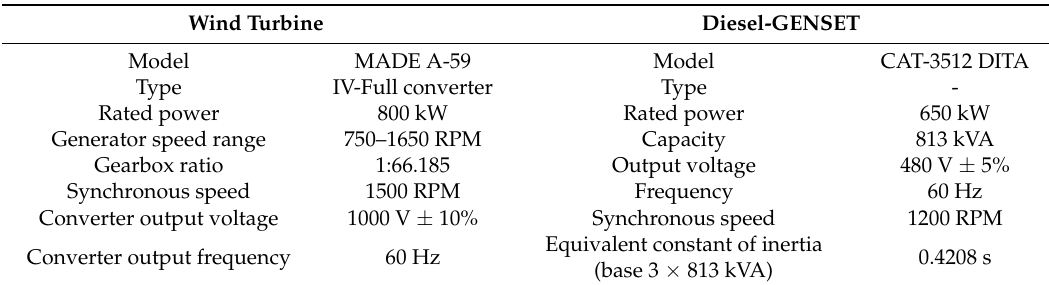
Figure 1. Wind-diesel hybrid power system of San Cristobal Island: ( a ) Layout diagram; ( b ) Load frequency control scheme. Table 1. Dataset of generation